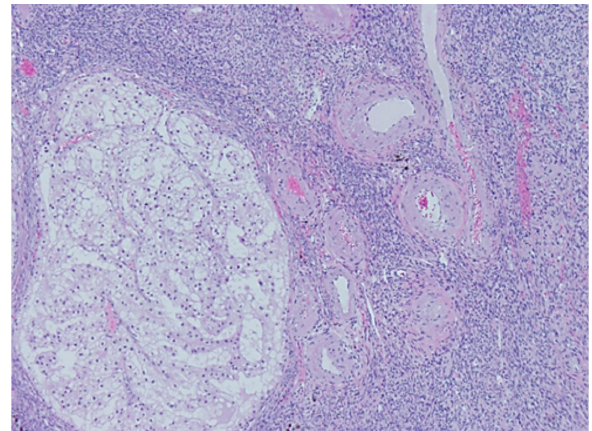
of clear cells surrounded by interconnecting vascular frame- work, consistent with the ultimate diagnosis of clear cell renal cell